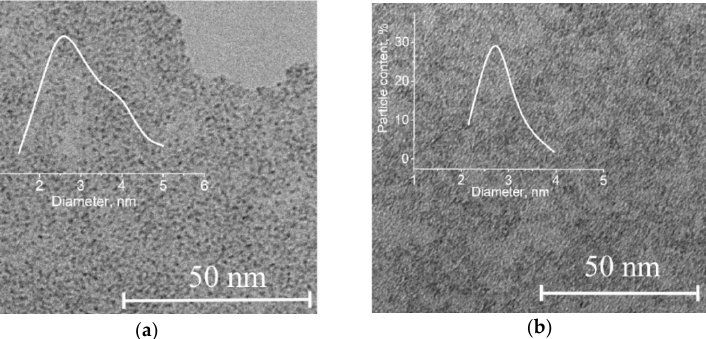
Figure 1. TEM images of particles and particle size distribution of molybdenum blue dispersions synthesized using various reducing agents: ( a ) glucose and ( b ) hydroquinone.